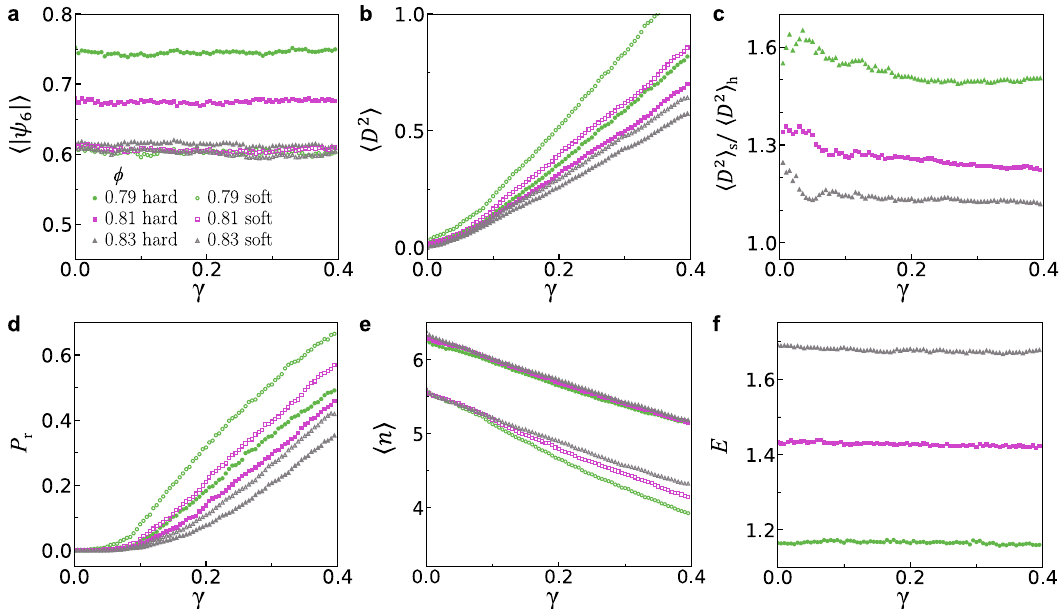
Fig. 6 Shear-induced changes for hard and soft particles at different packing fractions ϕ . a The average order parameter 〈 ∣ ψ 6 ∣ 〉 for hard and soft particles remain constant during the deformation at each density. The legend in ( a ) is for panels ( a – f ). b The average nonaf fi ne displacement 〈 D 2 〉 for hard and soft particles. c The ratio of 〈 D 2 〉 for hard to soft particles. d Deformation participation ratios P r 67 . e Mean number of long-lived neighbours n is insensitive to density for hard particles and more sensitive for soft particles as shear increases. n for soft particles are lower than that of hard particles because some soft particles are compressed smaller, and thus they have fewer neighbouring particles. f The average potential energy per particle under